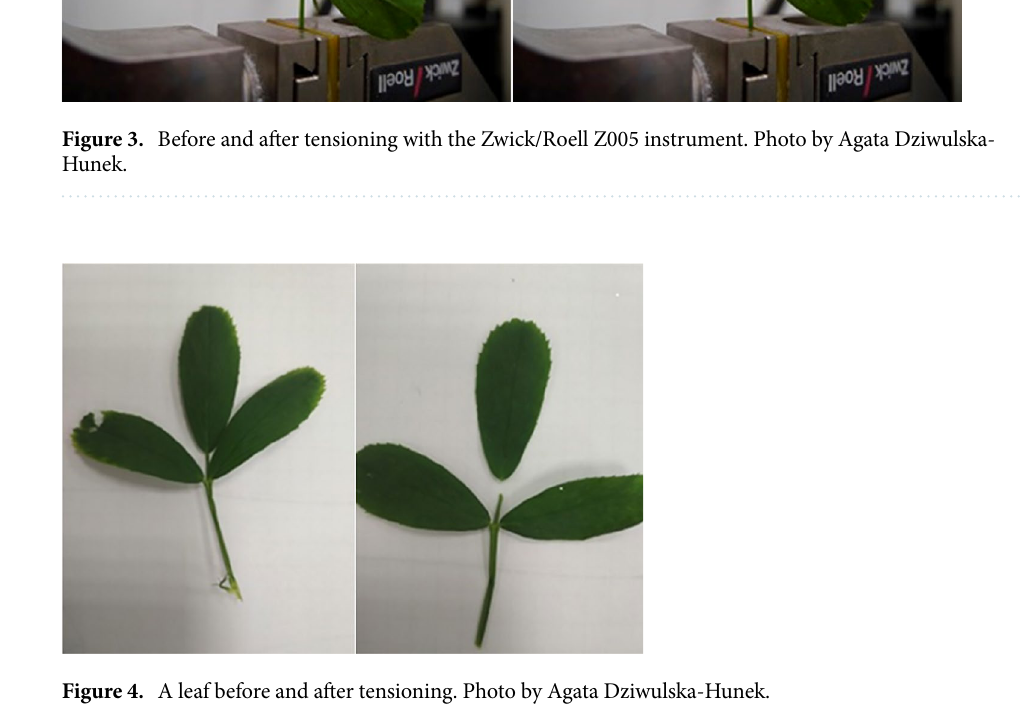
20 °C during the measurement. The tested leaves were collected from the top, middle, and bottom parts of plant stems (Fig. 5). Each sample measurement was repeated five times. Fluorescence lifetimes. Measurements of fluorescence decay were done using a K2 phase-modulation fluorimeter (ISS, USA). The leaves were crushed in a mortar in a Hepes–NaOH buffer (25 mM; pH 7.8) contain-